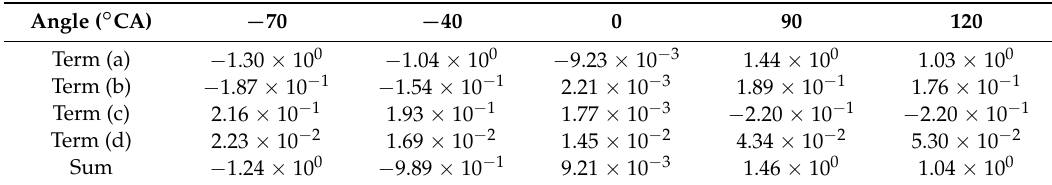
Table 1. Values of terms dependent on pressure